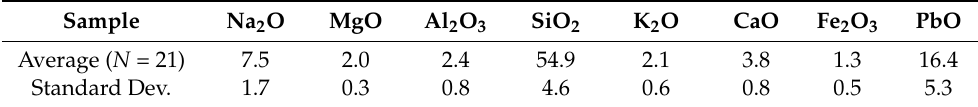
Table 9. Main oxide wt% averages with standard deviation for the mixed lead alkaline glazes (this